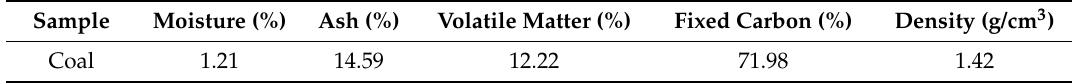
Table 1. Proximate analysis of the coal